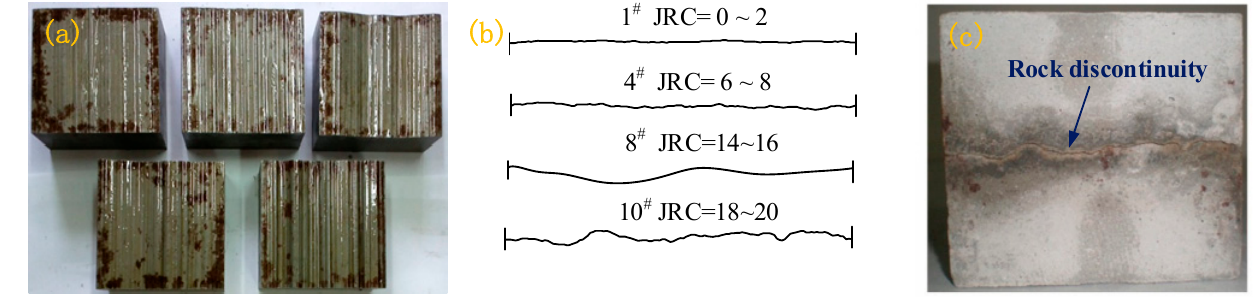
Figure 2. ( a ) Steel mold; ( b ) Barton’s standard profile lines; ( c ) sample.